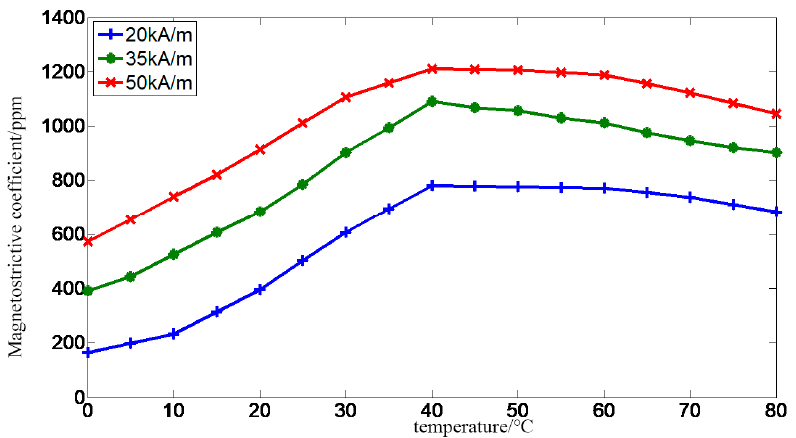
Figure 9. Relationship between giant magnetostrictive coe ffi cient and temperature.